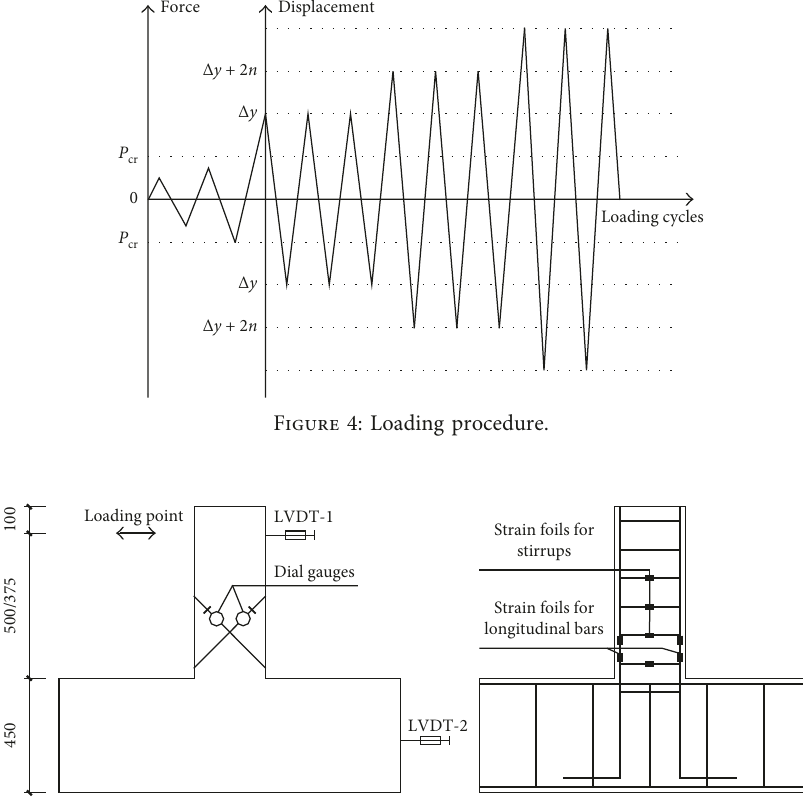
Figure 5: Measurement position.